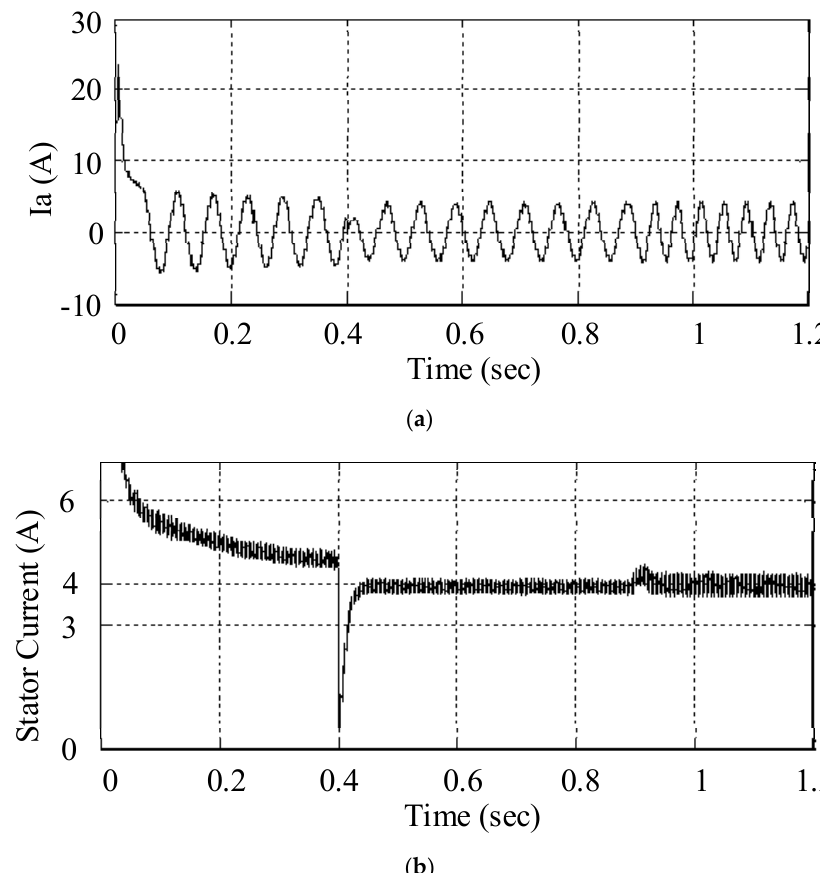
Figure 12. Speed and flux control using BELBIC. ( a ) Stator phase current, ( b ) current vector of total stator.